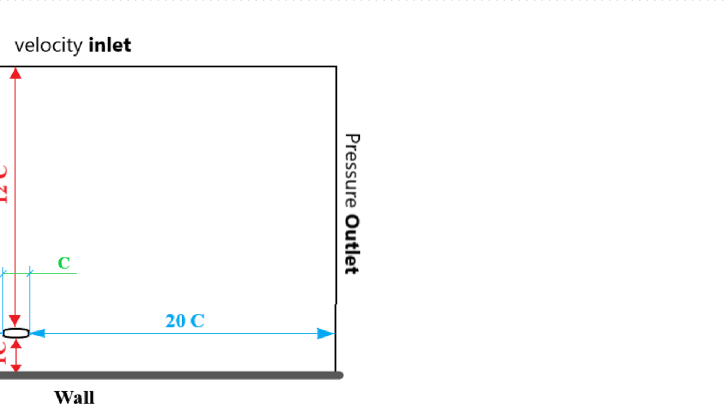
Figure 2. Computational domain and applied boundary conditions around